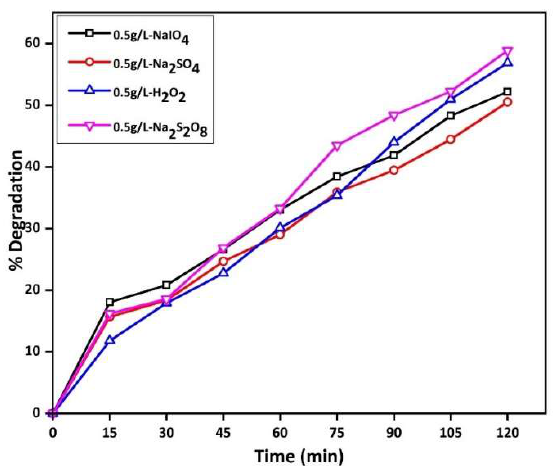
Figure 7. Degradation of ANB with different oxidants (pH = 3.0 ± 0.2, ANB = 50 ppm, FFGN = 0.5 g/L, Amplitude = 40%, Probe = 25 mm, T = 25 ± 1 °C) .